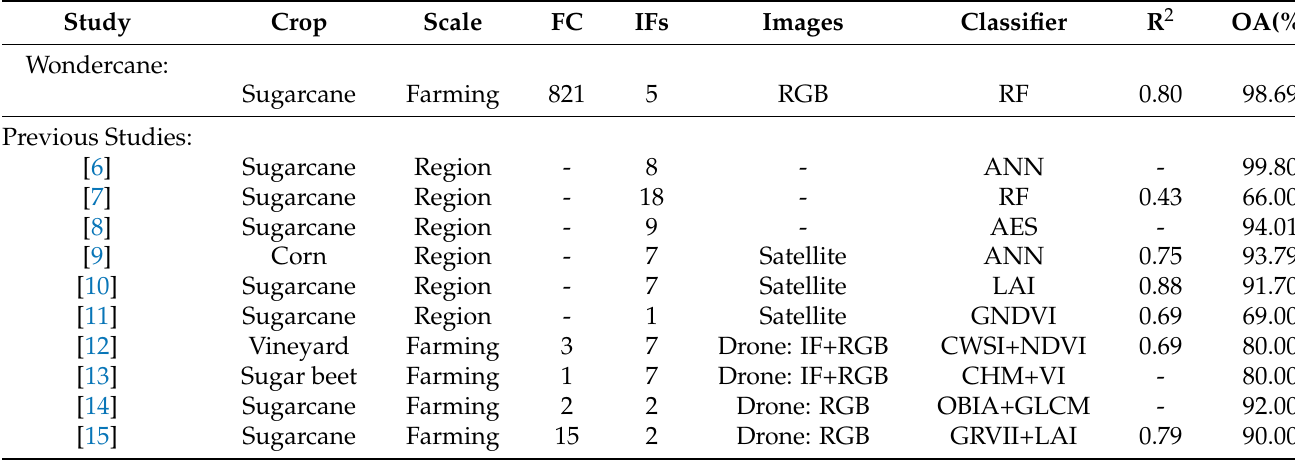
Table 5. Overview of the Wondercane model in comparison to ten previous studies, looking at key features as well as final correlation and